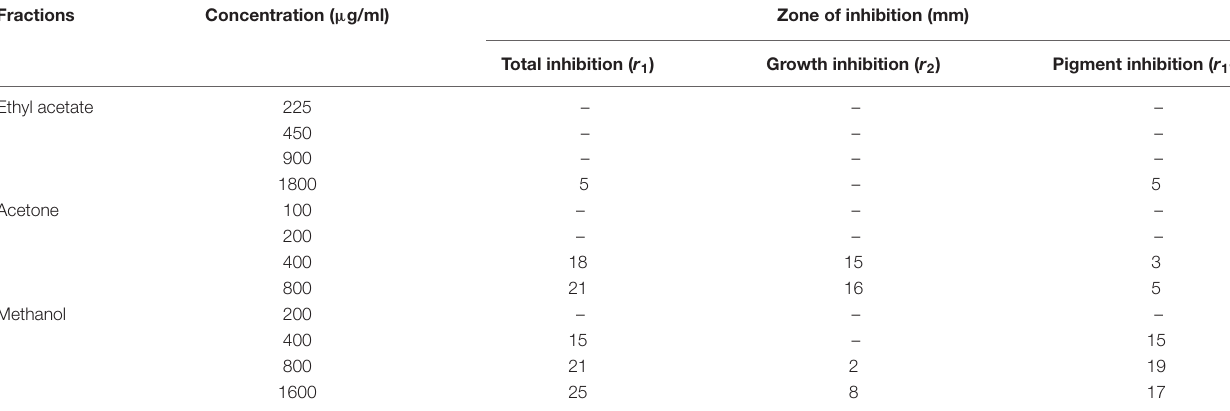
TABLE 1 | Inhibition of C. violaceum (CV12472) pigments by different fractions of Mangifera indica . Fractions